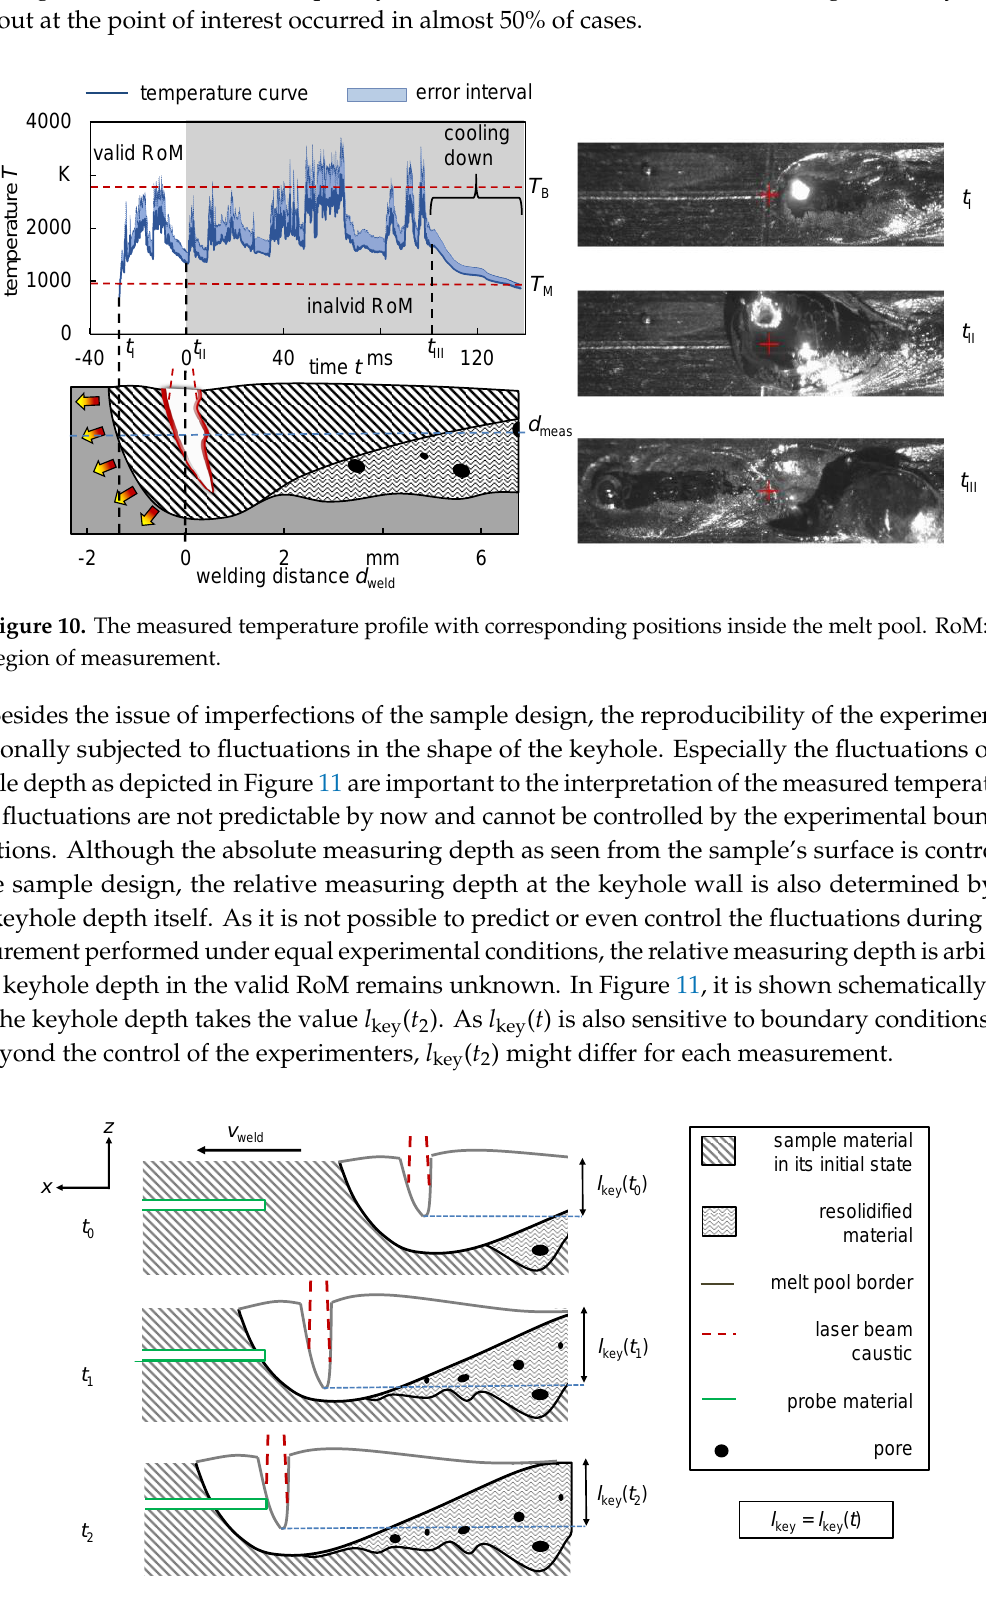
Figure 11. Schematic of the relative position between the probe and the melt pool during different phases of the ongoing measurements.